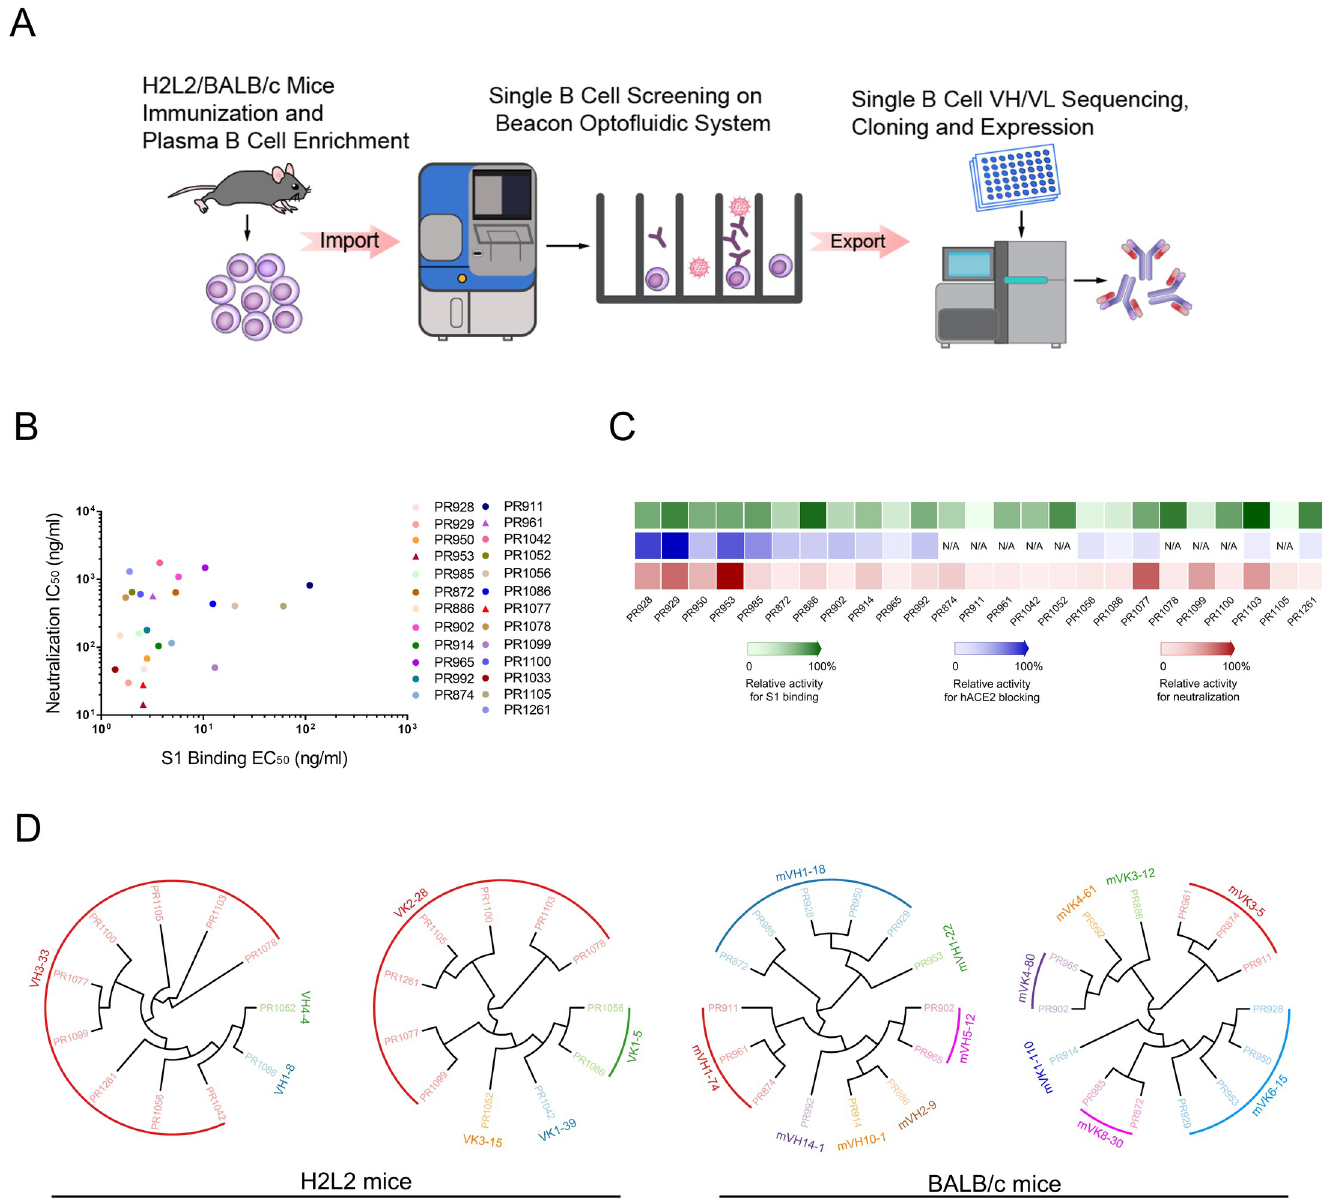
Fig 1. Analysis of plasma responses to SARS-CoV-2 proteins and antibody identification from H2L2 transgenic and BALB/c mice by single cell sequencing. (A) Schematic diagram of antibody identification from convalescent patients by single cell sequencing. Both Harbour H2L2 transgenic mice and BALB/c mice were immunized with SARS-CoV-2 RBD protein. SARS-CoV-2 RBD protein binding B cells were isolated from enriched mouse spleen and bone marrow cells with beads conjugated with biotinylated SARS-CoV-2 RBD protein. Paired VH and VL of each cell were recovered by single B cell sequencing. The sequences were used for subsequent antibody construction and expression. (B) Antibodies neutralization IC 50 ( y axis) are plotted against SARS-CoV-2 S1 protein binding EC 50 ( x axis), PR1077, PR953, and PR961 are shown as triangle, and other antibodies are shown as dot. All the data of this figure can be found in the S1 Data file. (C) Heat map shows the relative levels of SARS-CoV-2 S1 binding, hACE2 blocking, and live virus neutralization. The depth of color is proportional to the effect of the antibody (green, S1 binding activity; blue, hACE2 blocking activity; red, neutralizing activity). All the data of this figure can be found in the S2 Data file. (D) Phylogenetic analysis of the relationship between antibody variable gene segments and germline. The relationships between the heavy and light chain variable regions and the germlines from H2L2 transgenic (left) and BALB/c (right) mouse antibodies are shown. hACE2, human angiotensin-converting enzyme 2; RBD, receptor-binding domain; SARS-CoV-2, Severe Acute Respiratory Syndrome Coronavirus